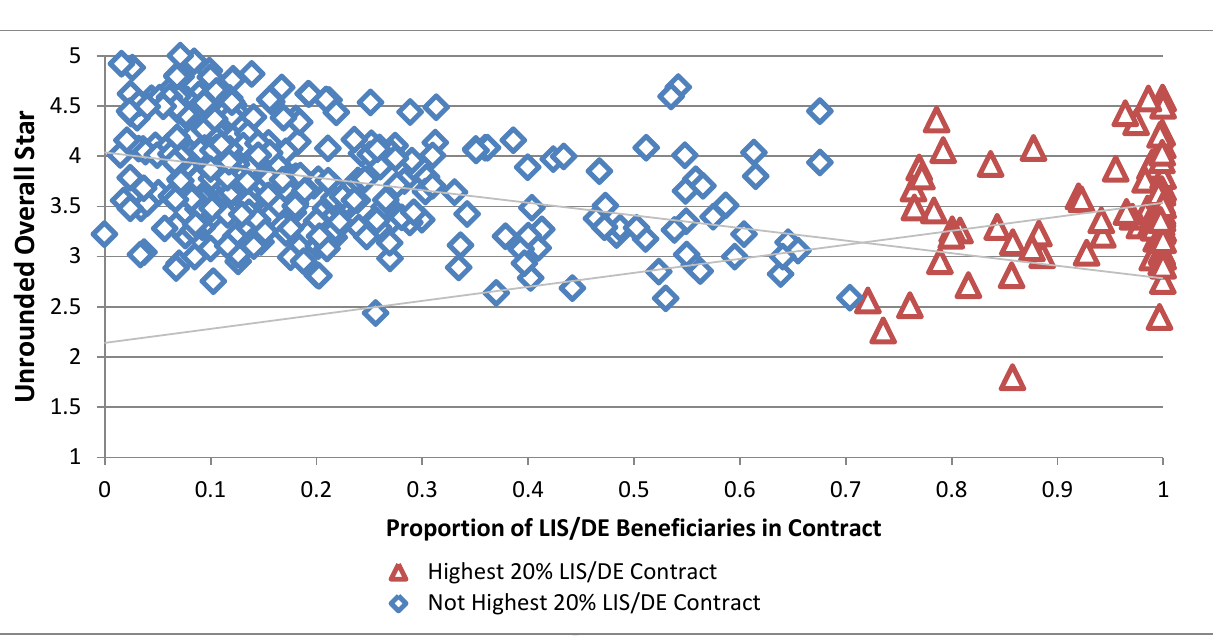
Figure 14.1: Relationship between Proportion Dually-Enrolled/Low-Income-Subsidy Status and Medicare Advantage Quality Star Rating